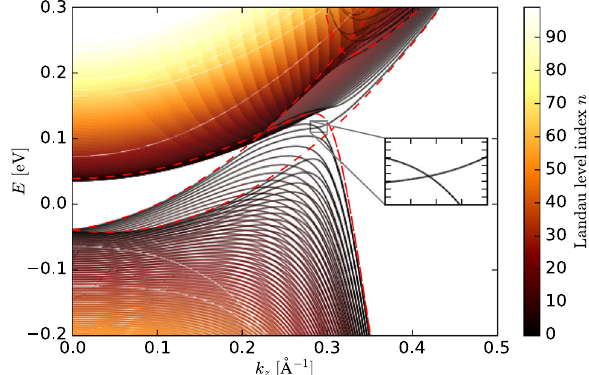
FIG. 6. Landau levels for a magnetic field of 20 T applied parallel to the C 3 axis. The calculation is done with the k · p model of Eq. (B3) describing ZrTe. The dashed red lines show the bulk bands and the inset reveals the crossing of the two chiral Landau